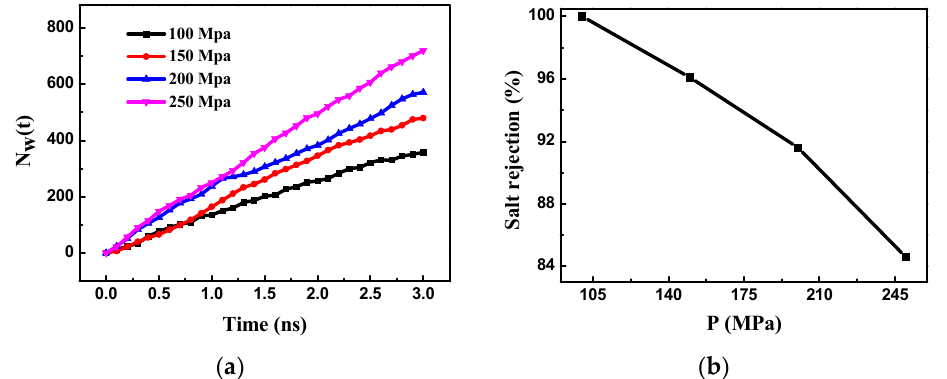
Figure 4. ( a ) The number of water molecules passing through the bilayer porous graphene membrane over time for different external pressures; ( b ) effect of external pressure on the salt rejection of the Figure 4. ( b ) effect of external pressure on the salt rejection of the bilayer porous graphene bilayer porous graphene membrane. membrane.